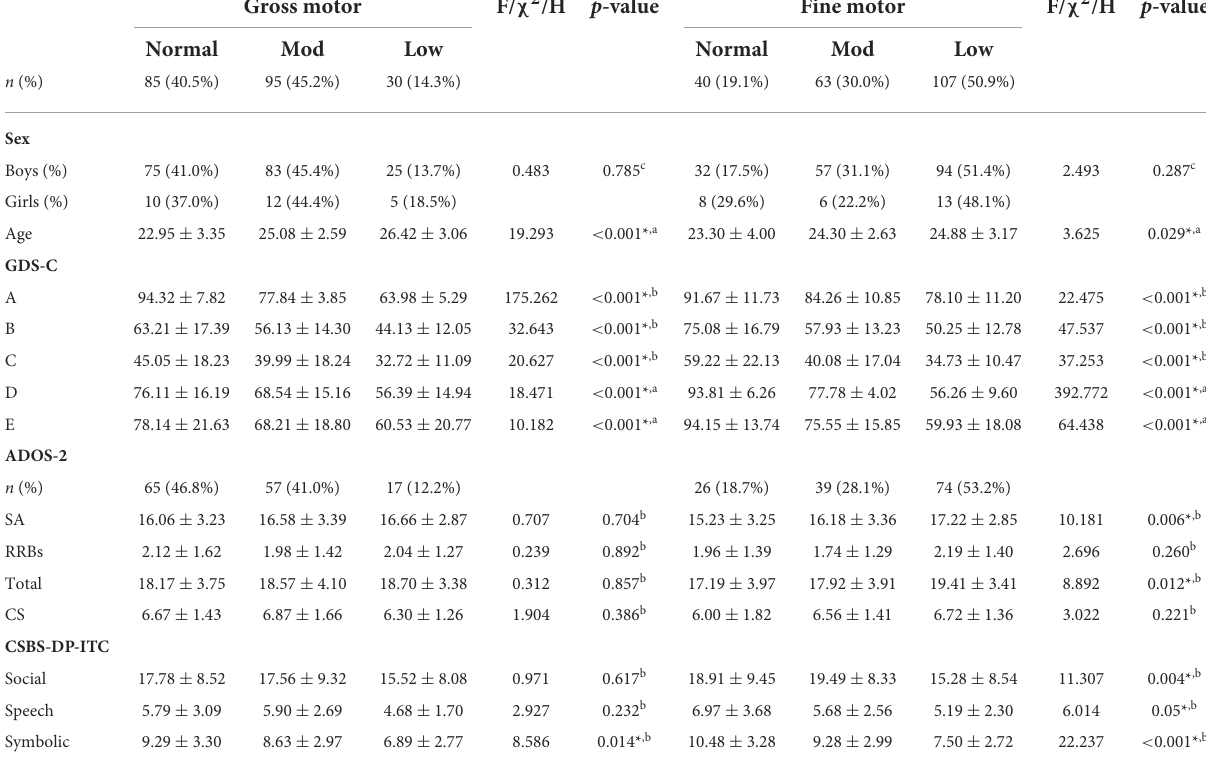
TABLE 2 Developmental scores and ASD symptoms of participants with different degrees of motor dysfunction. Gross motor F/ χ 2 /H p- value Fine motor F/ χ 2 /H p -value Normal Mod Low Normal Mod Low 40 (19.1%) 107